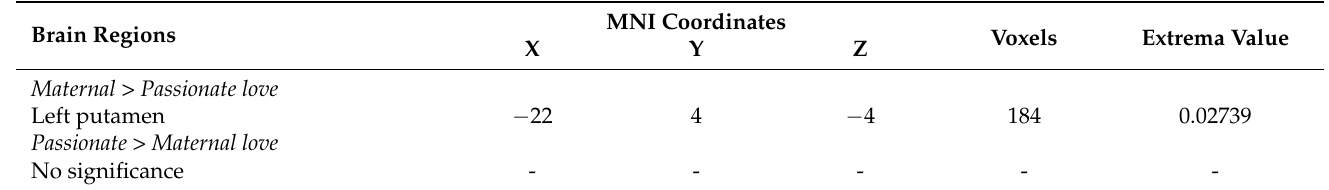
Table 4. Coordinates of the maxima in the activated brain regions, contrasting between maternal and passionate love across